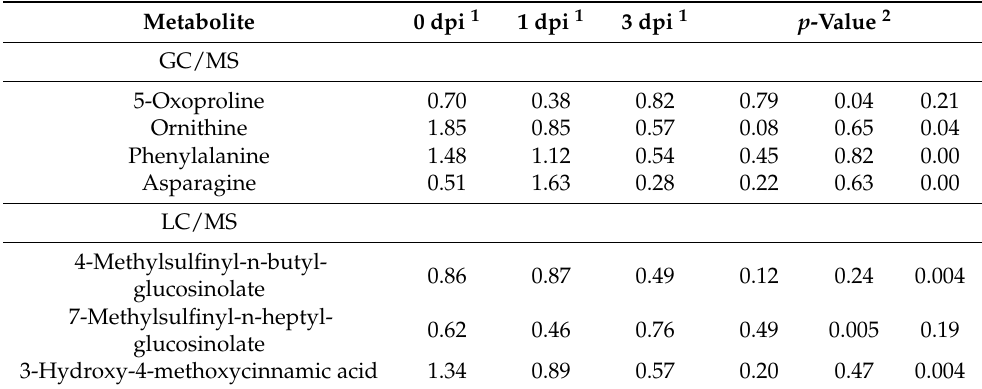
Table 1. Ratio of primary and secondary metabolites accumulation ( mfdx1-1 /WT) upon P. syringae pv. tomato DC3000 infection.